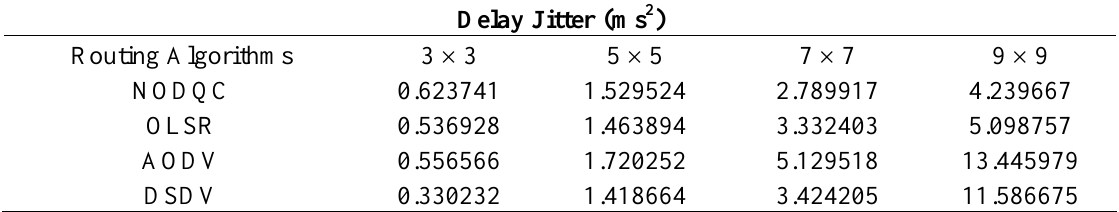
Table 11. Experiment results of routing algorithms (delay jitter).